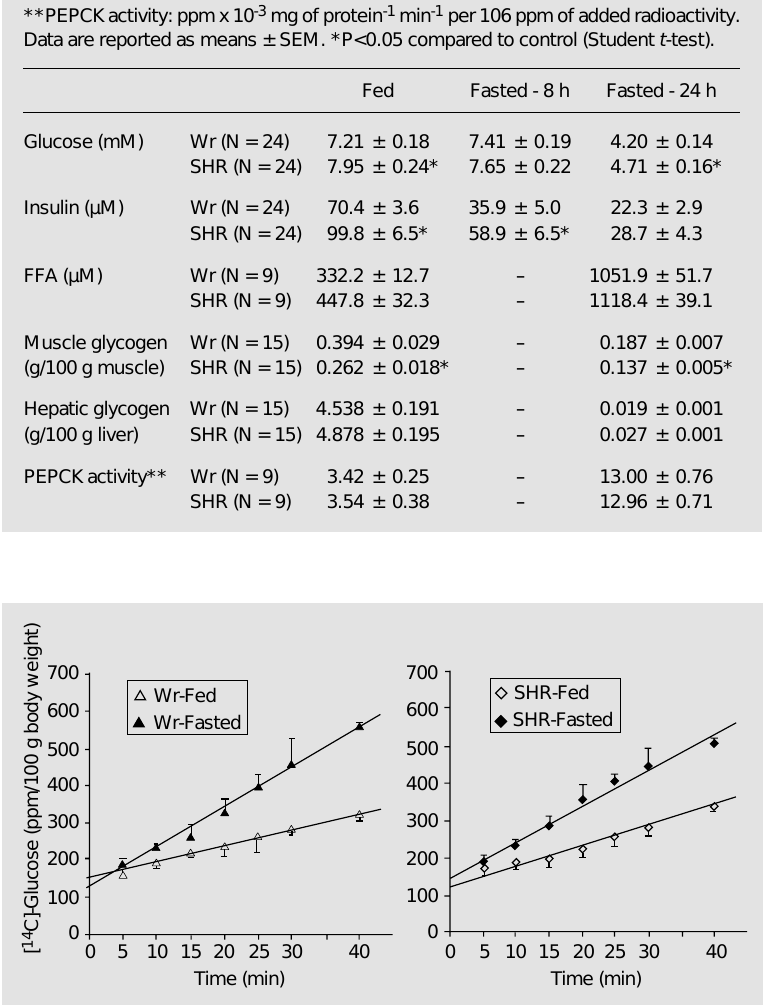
Figure 1 - [ 14 C]-Bicarbonate incorporation into circulating glucose during continuous infusion of [ 14 C]-bicarbonate in SHR and Wistar rats (Wr) in the fed state and after a